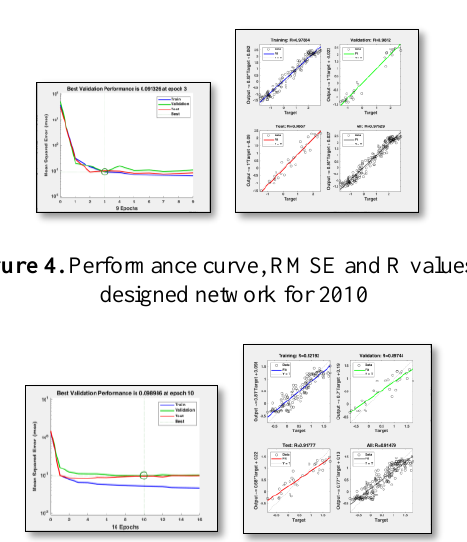
Figure 5. Performance curve, RMSE and R values of designed network for 2015